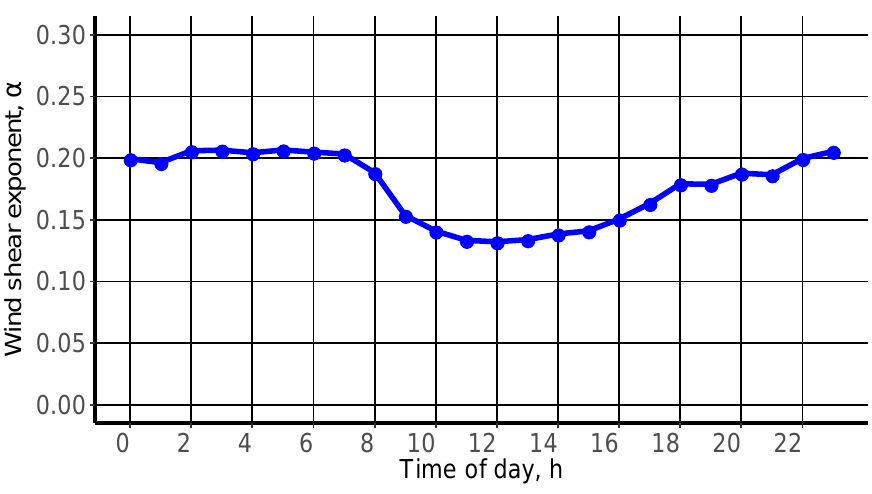
Figure 6. Hourly variation of the wind shear exponent for a typical day at La Ventosa, Oaxaca, Mexico.